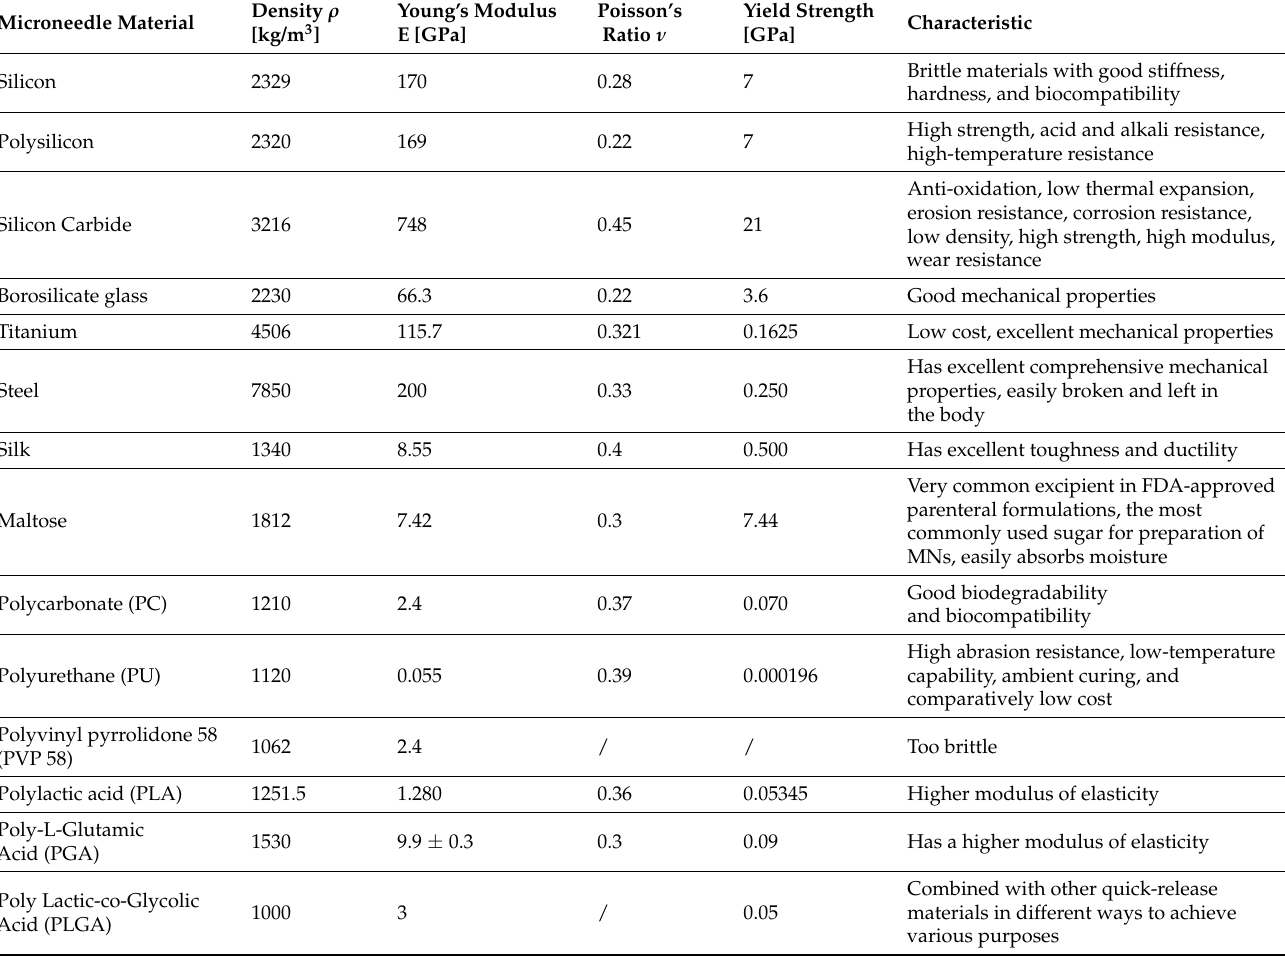
Table 1. The mechanical parameters and features of common microneedle matrix materials